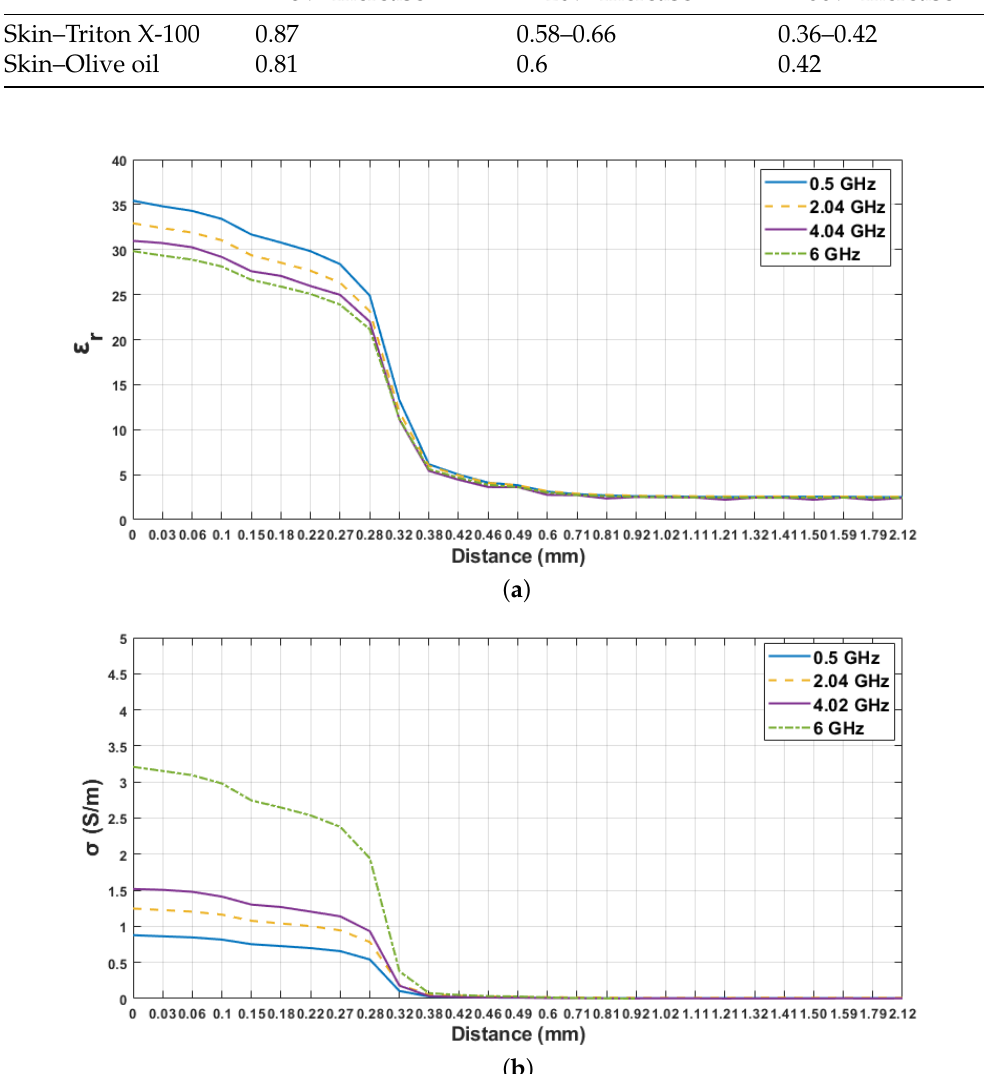
Figure 12. Skin–olive oil dielectric properties as a function of probe distance from the first layer at 0.5, 2.04, 4.02 and 6 GHz frequency points: ( a ) relative permittivity, ( b )